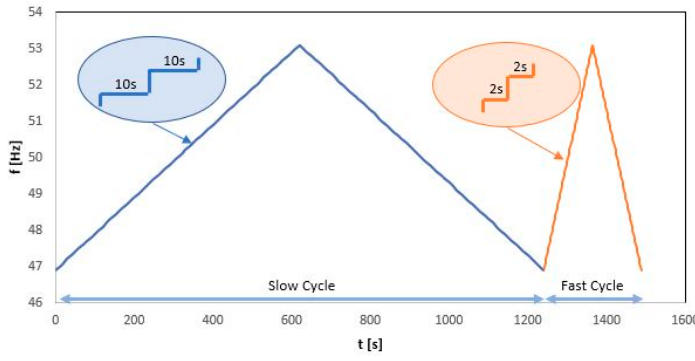
Figure 2. Specific time conditions during the measurement of selected devices.